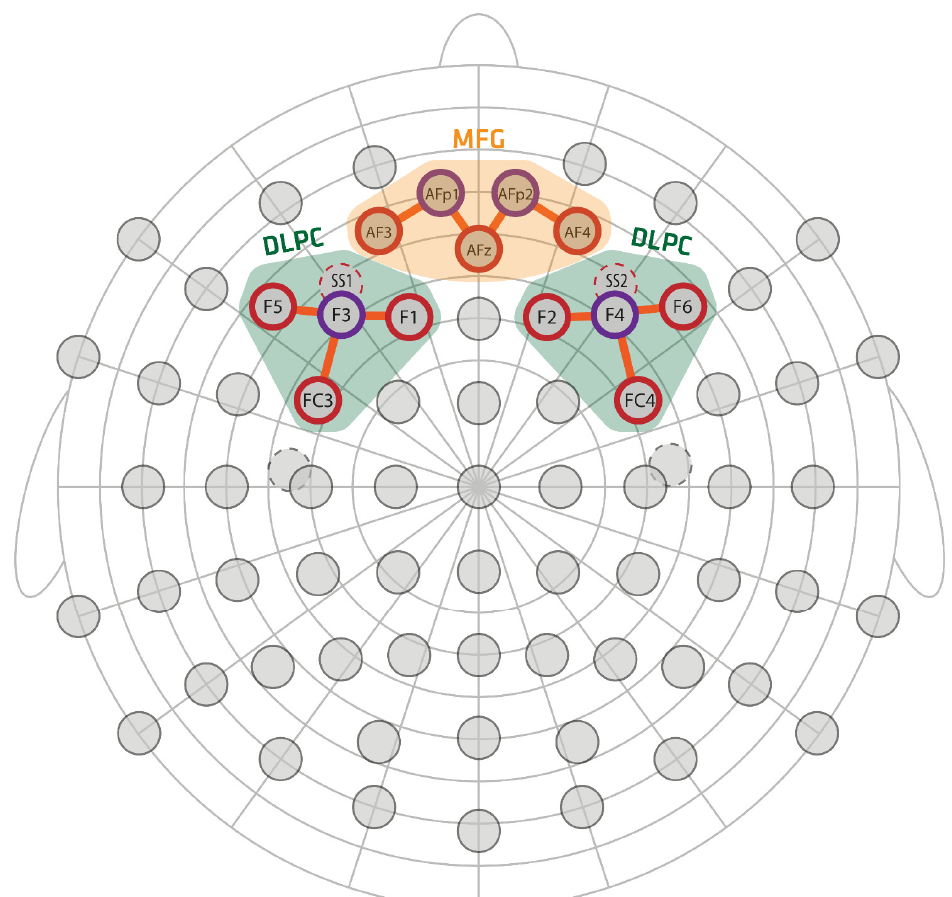
Figure 3. Optode montage. The source ′ s positions are red, and the detectors are purple. The colored fields indicate the regions of interest: green (DLPFC) and orange (MFG). The orange lines indicate the location of the fNIRS channels.